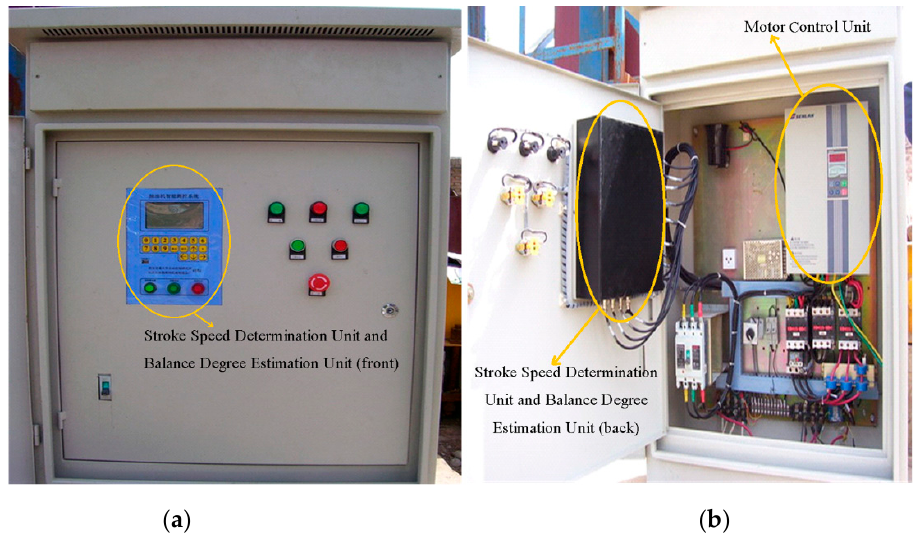
Figure 4. Physical appearance of the controller for stroke speed adjustment and balance estimation. ( a ) Front panel of the controller; and ( b ) inner construction of the controller.